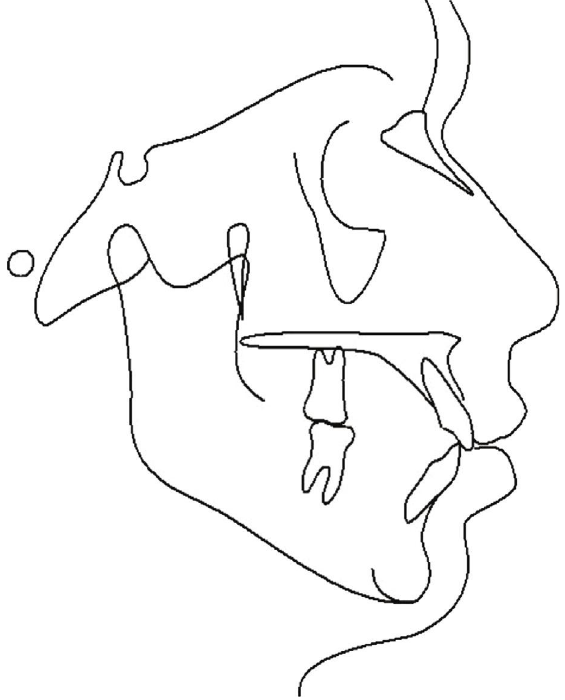
Figure 5: Initial cephalometric